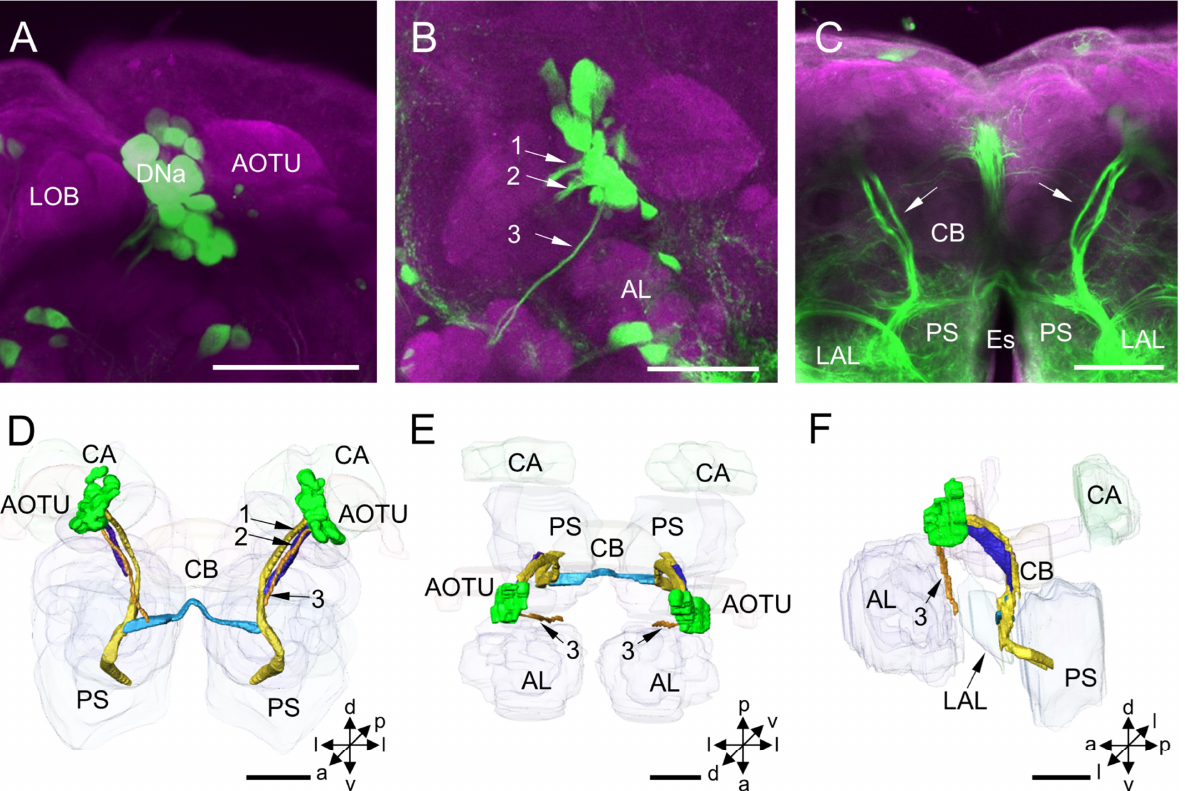
Figure 2. Distribution and projection patterns of DNa neurons in the brain: ( A – C ) projection views of confocal stack images showing DNa somata and primary neurites (arrows, No. 1–3); and ( D – F ) the anterior, dorsal, and lateral views of the three-dimensional reconstruction showing DNa somata and primary neurites in the brain. AOTU, anterior optic tubercle; AL, antennal lobe; CA, calyx; CB, central body; LAL, lateral accessory lobe; Es, esophagus; LOB, mushroom body lobes; PS, posterior slope. a, anterior; d, dorsal; l, lateral; p, posterior; v, ventral. Scale bars: 100 μ m.